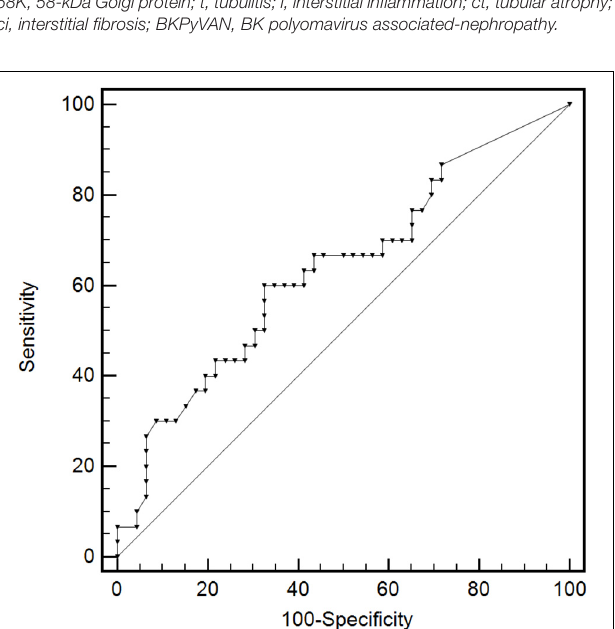
Table 3 . When grouped by different plasma viral load thresholds, the mean extent of SV40-T staining in renal allograft was significantly more extensive in patients with plasma BKPyV- DNA load ≥ 10 5 copies/mL than those with plasma BKPyV-DNA